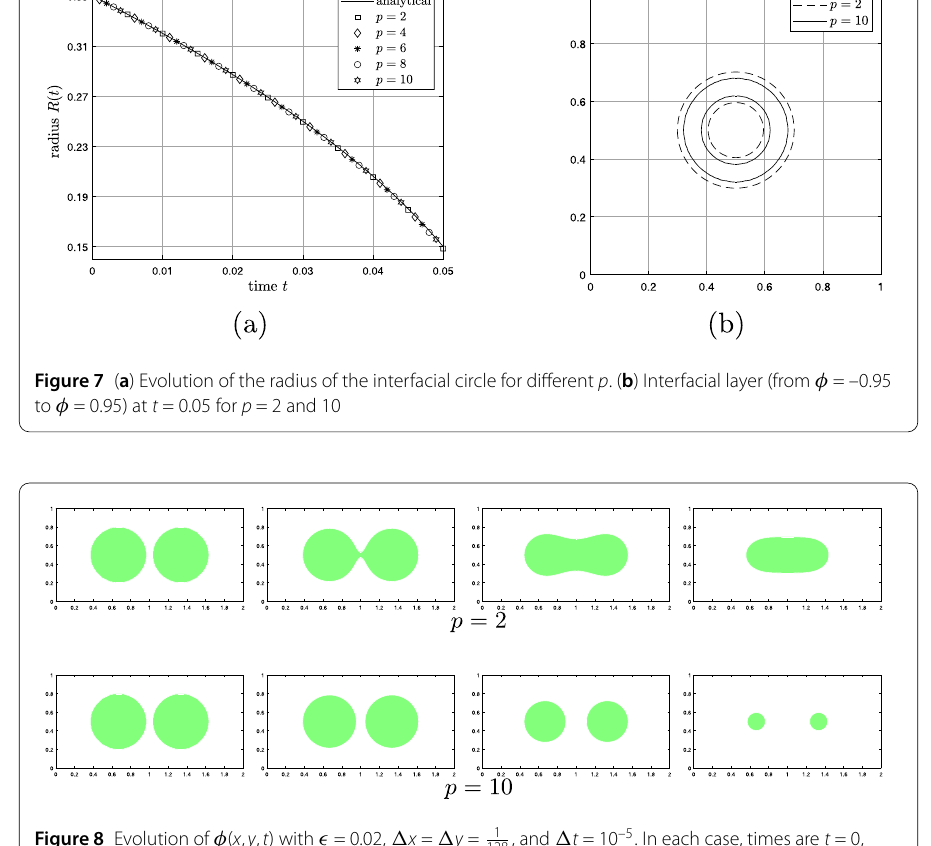
, and (cid:7) t = 10 –5 . In each case, times are t = 0, 128